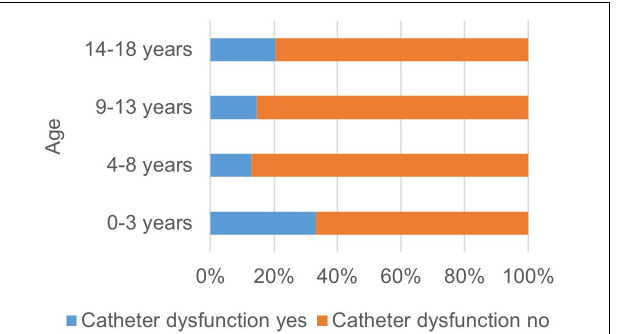
FIGURE 1 | Occurrence of catheter dysfunctions related to the age of the patient. The occurrence of catheter related problems was significantly associated with younger age ( p =